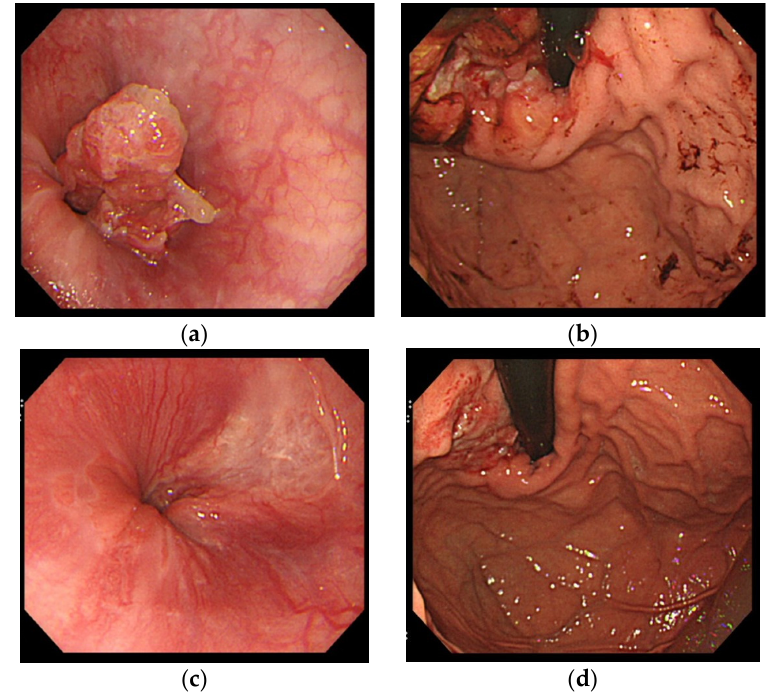
Figure 2. Gastrointestinal fiberscope (GIF) revealed esophageal invasion ( a ) and an advanced gastric cancer type 3 in cardia ( b ) before the initiation of chemo-immunotherapy. After four cycles of chemo-immunotherapy in combination with trastuzumab, esophageal tumor completely disappeared, leaving a whitish area ( c ), and both round wall and ulceration became flattened ( d ).